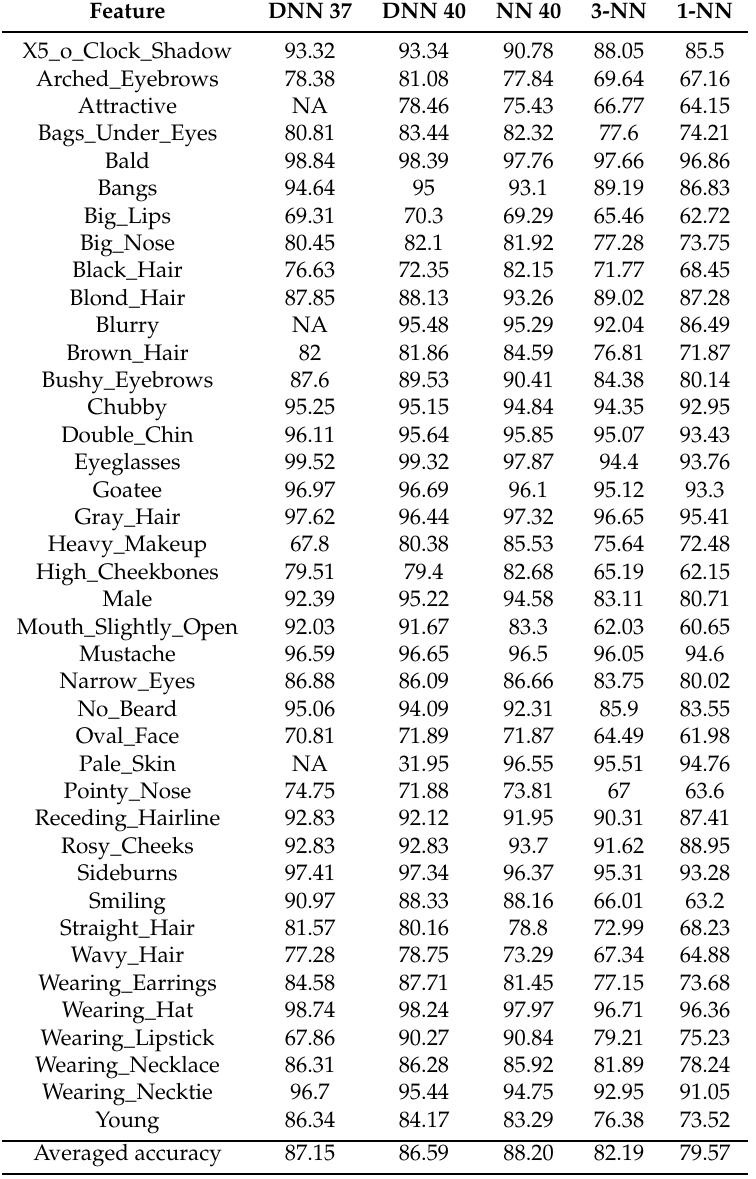
Table 3. Accuracy (expressed in percentage) of each classifier on each